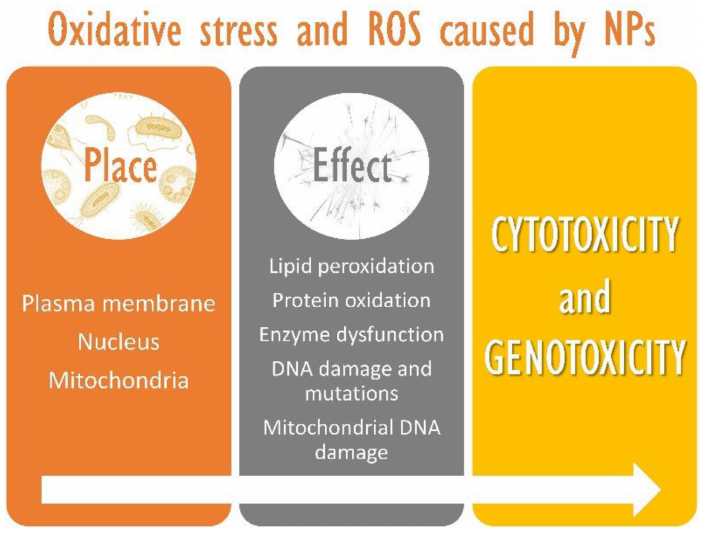
Figure 6. Potential cellular toxic effects of nanoparticles (NPs) caused by reactive oxygen species